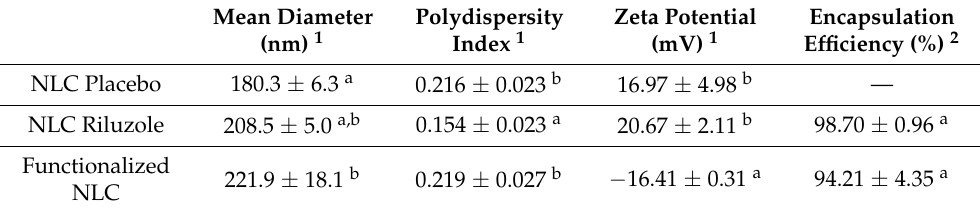
Table 2. Mean diameter, polydispersity index, zeta potential, and encapsulation efficiency of NLC formulations on day 0. Values are expressed as the mean ± SD ( n =